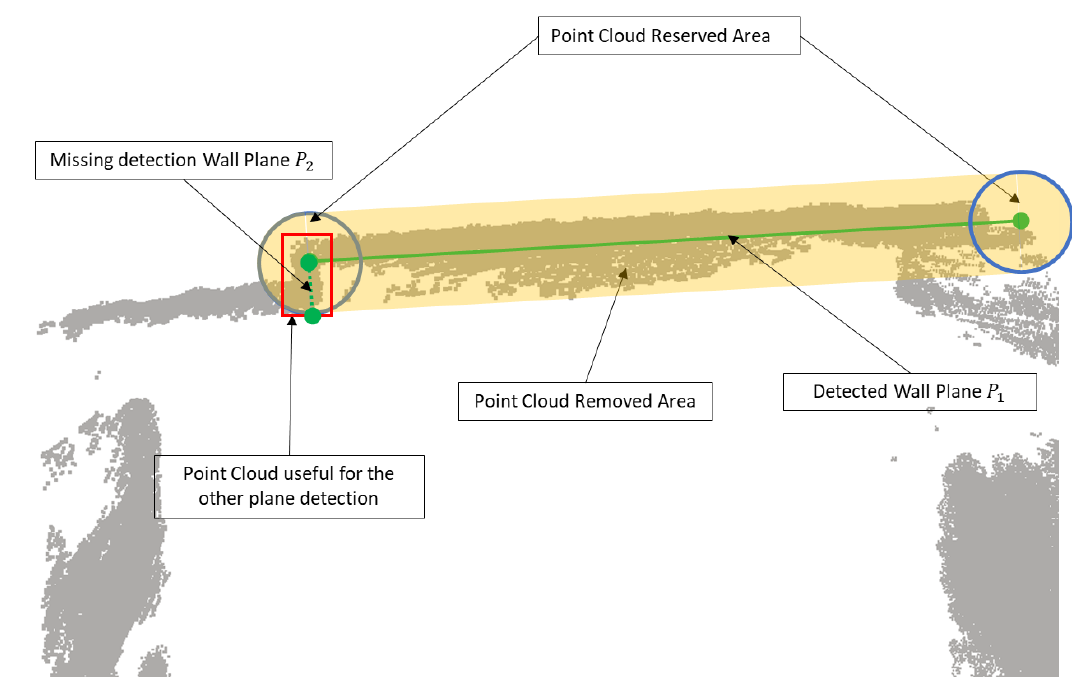
Figure 9. Description of the over removing problem as well as the proposed solution.